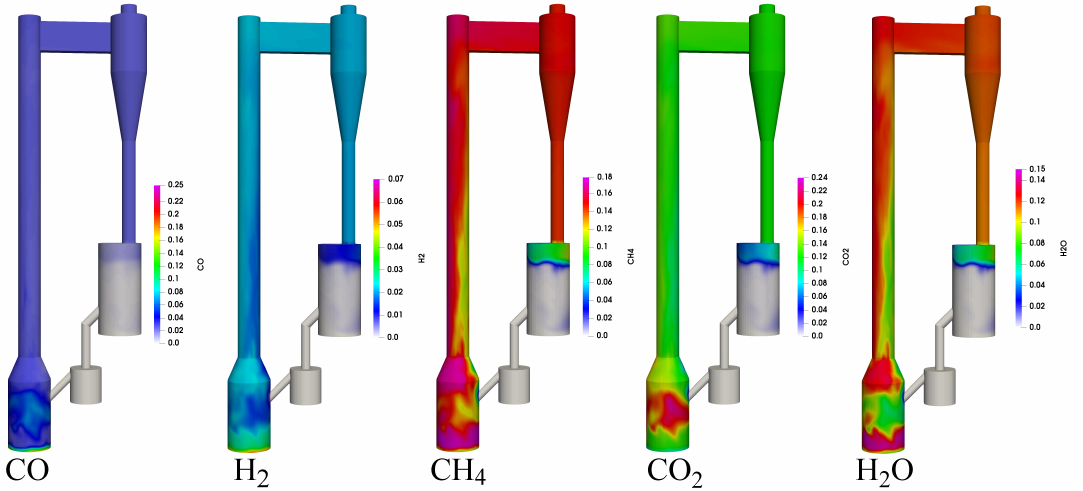
Figure 9. Contours of mass fraction of gas species. N 2 is used as balance gas. Temperature is 400 ◦